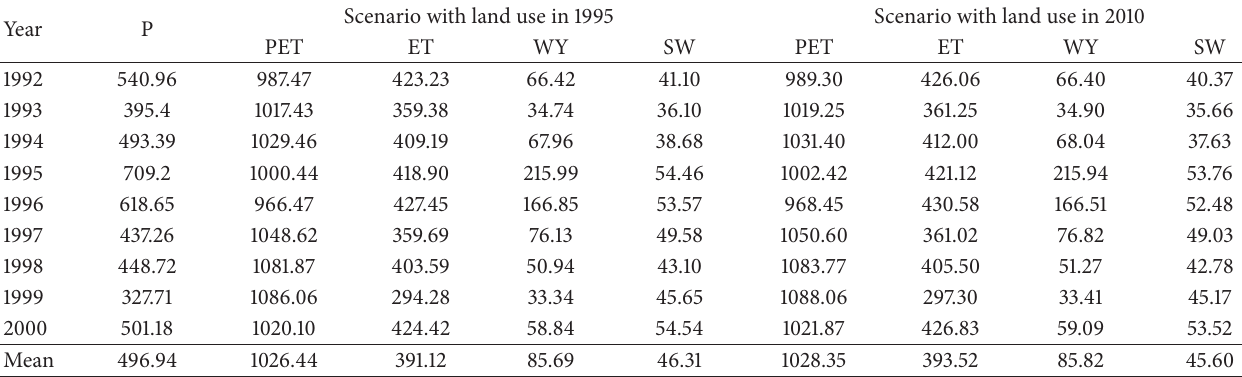
Table 5: Annual basin values of hydrologic features for the Upper Fenhe River watershed on the different land use from 1992 to 2000 (mm). Scenario with land use in 1995 Year P 540.96